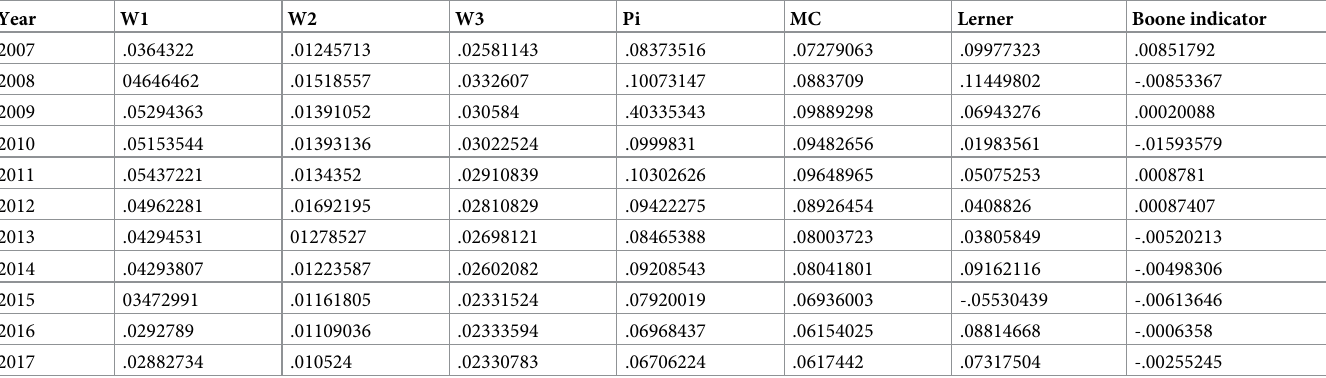
Table 5. Annual summary statistics for variables of Lerner index and Boone